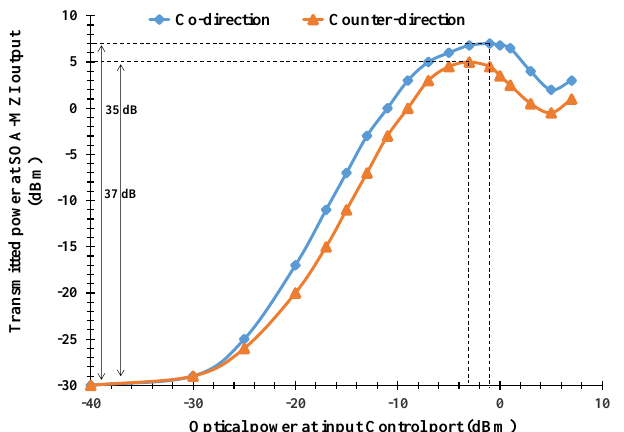
Figure 3. Static characteristic of the SOA-MZI that represents the transmitted power at the SOA-MZI out as a function of the input optical power at SOA-MZI MP. The contrast ratio (CR) equal to 37 dB is achieved for the co-direction schema and CR equal to 35 dB is achieved for the counter- direction one.